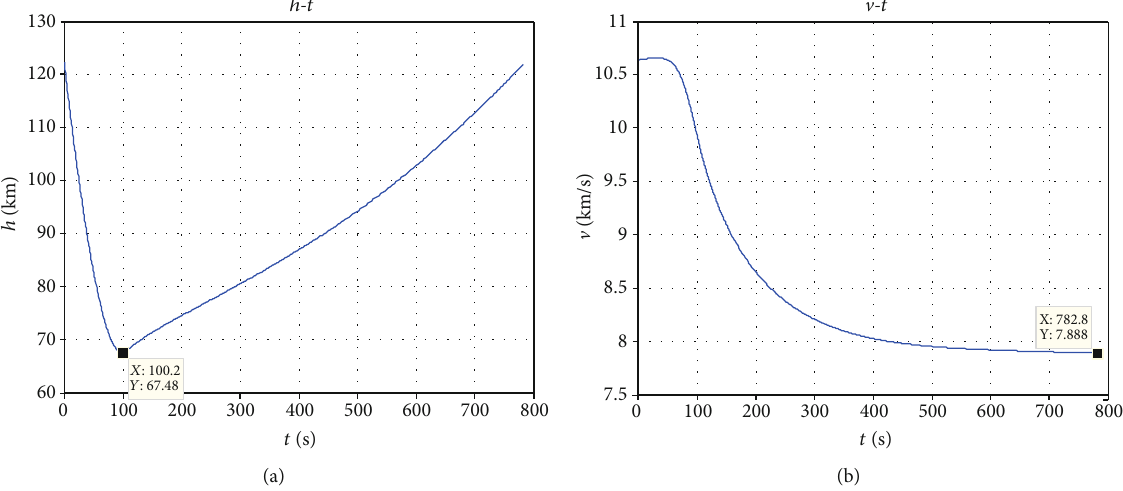
Figure 8: Time history of (a) geocentric altitude h and (b) velocity v .